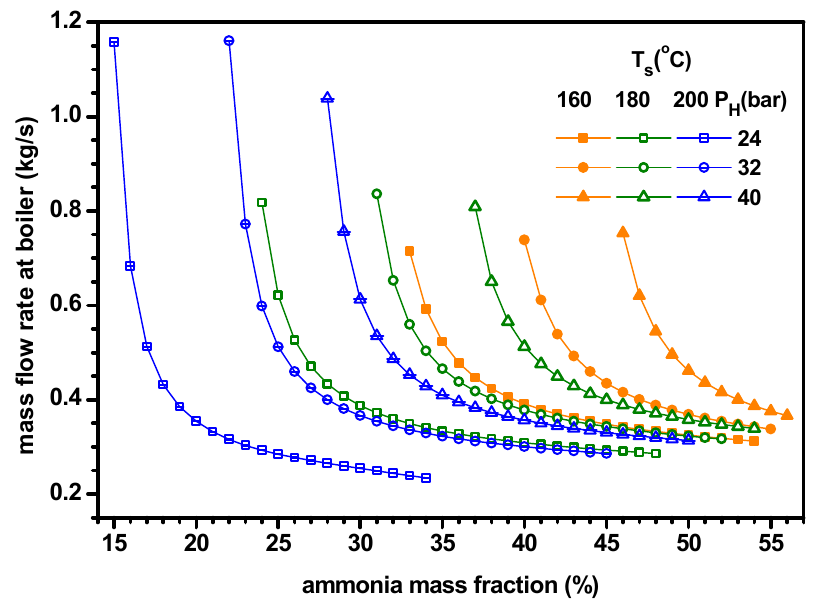
Figure 6. Heat input rate for varying ammonia fraction.